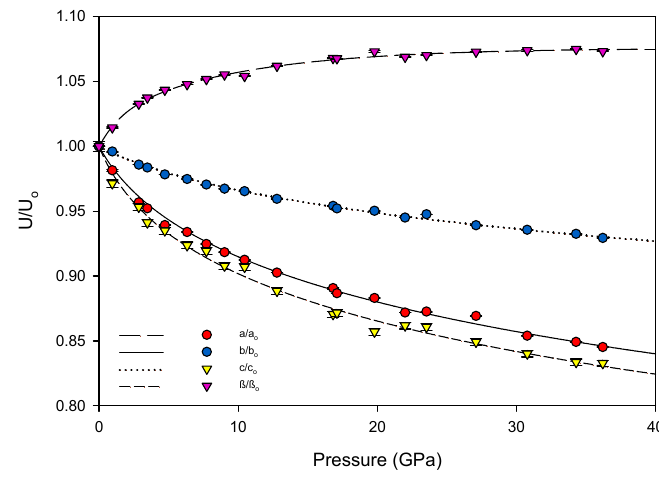
Figure 5. Evolution of normalized unit cell parameters of melamine with pressure. Linear axial compressibilities are β a0 = 6.54(5) × 10 − 3 GPa − 1 , β b0 = 1.89(1) × 10 − 3 GPa − 1 , and β c0 = 9.0(1) × 10 − 3 GPa − 1 .